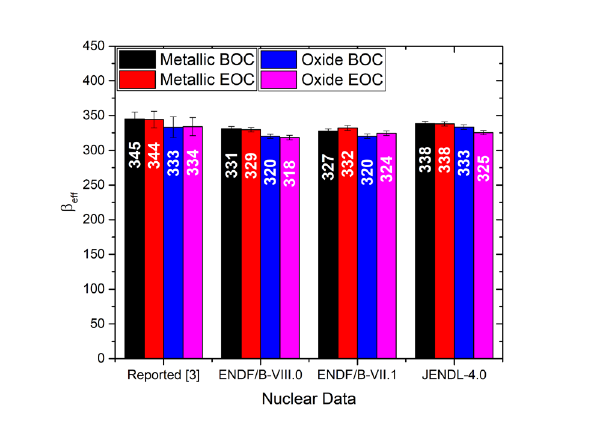
Table 4. Impact of the specific isotope library from